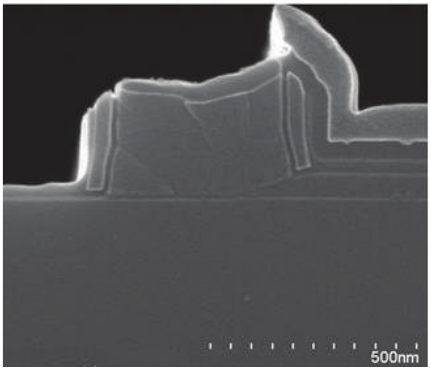
Figure 2: Cross-sectional SEM view of fabricated step gate oxide structure.